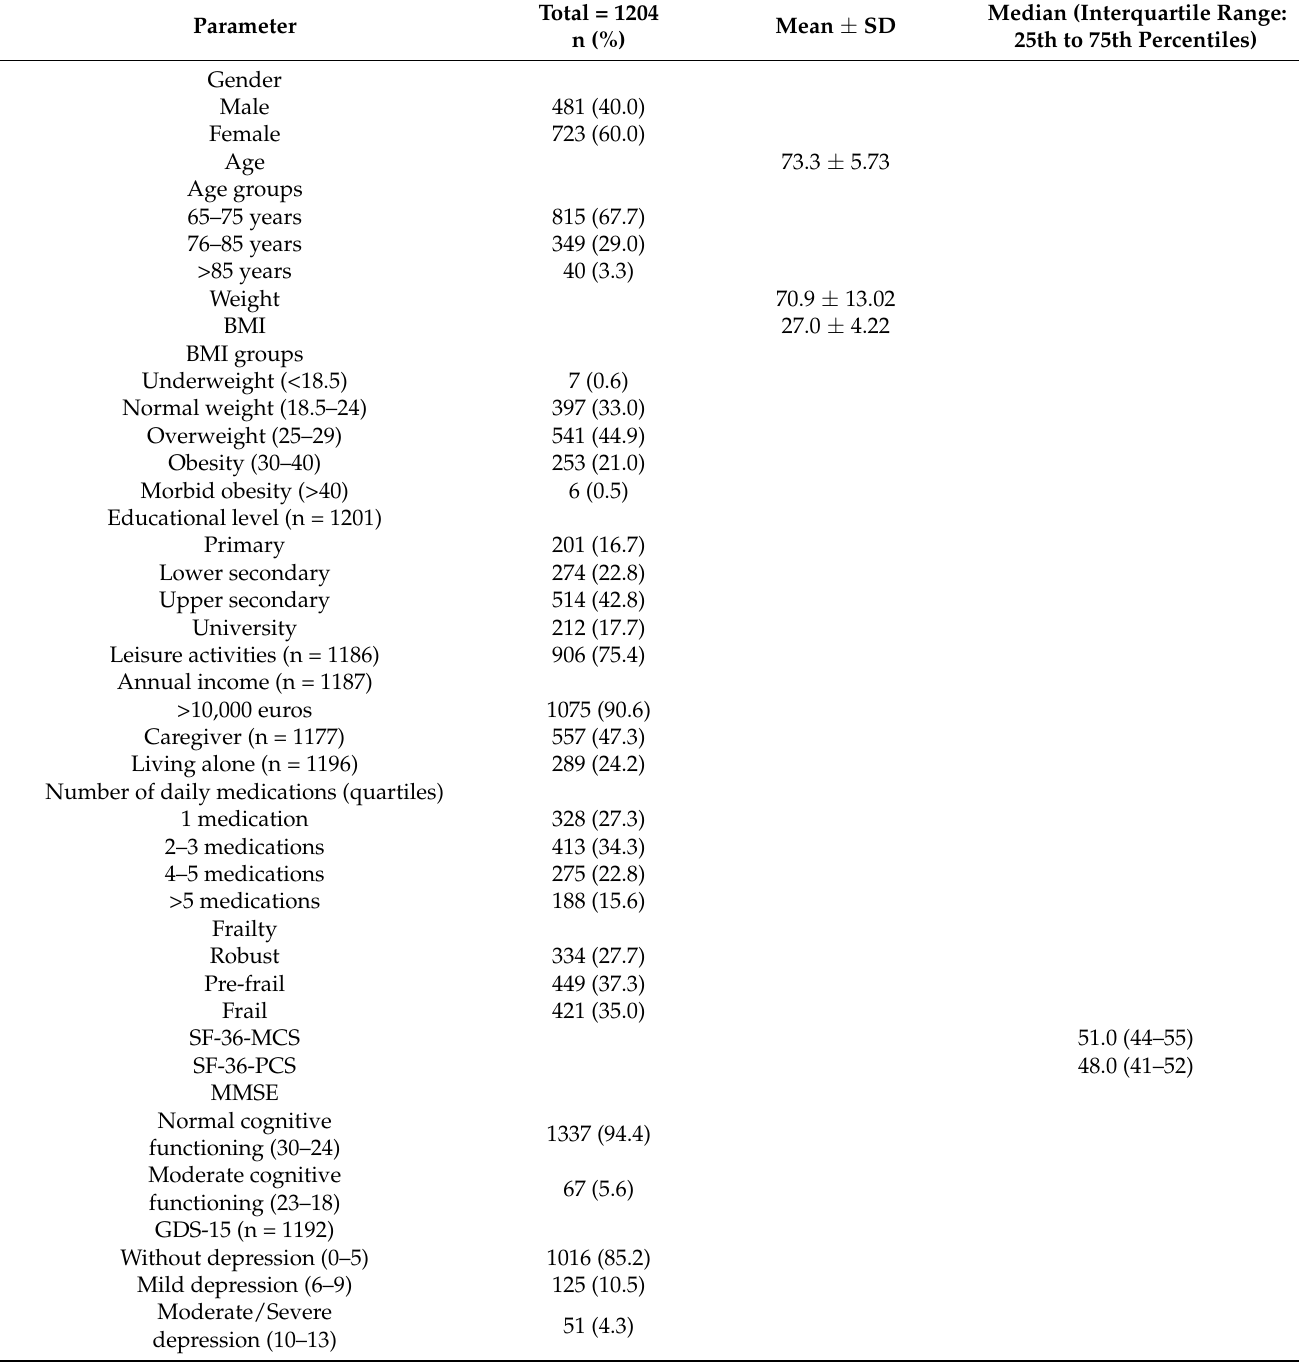
Table 1. Characteristics of the FRASNET participants analyzed for